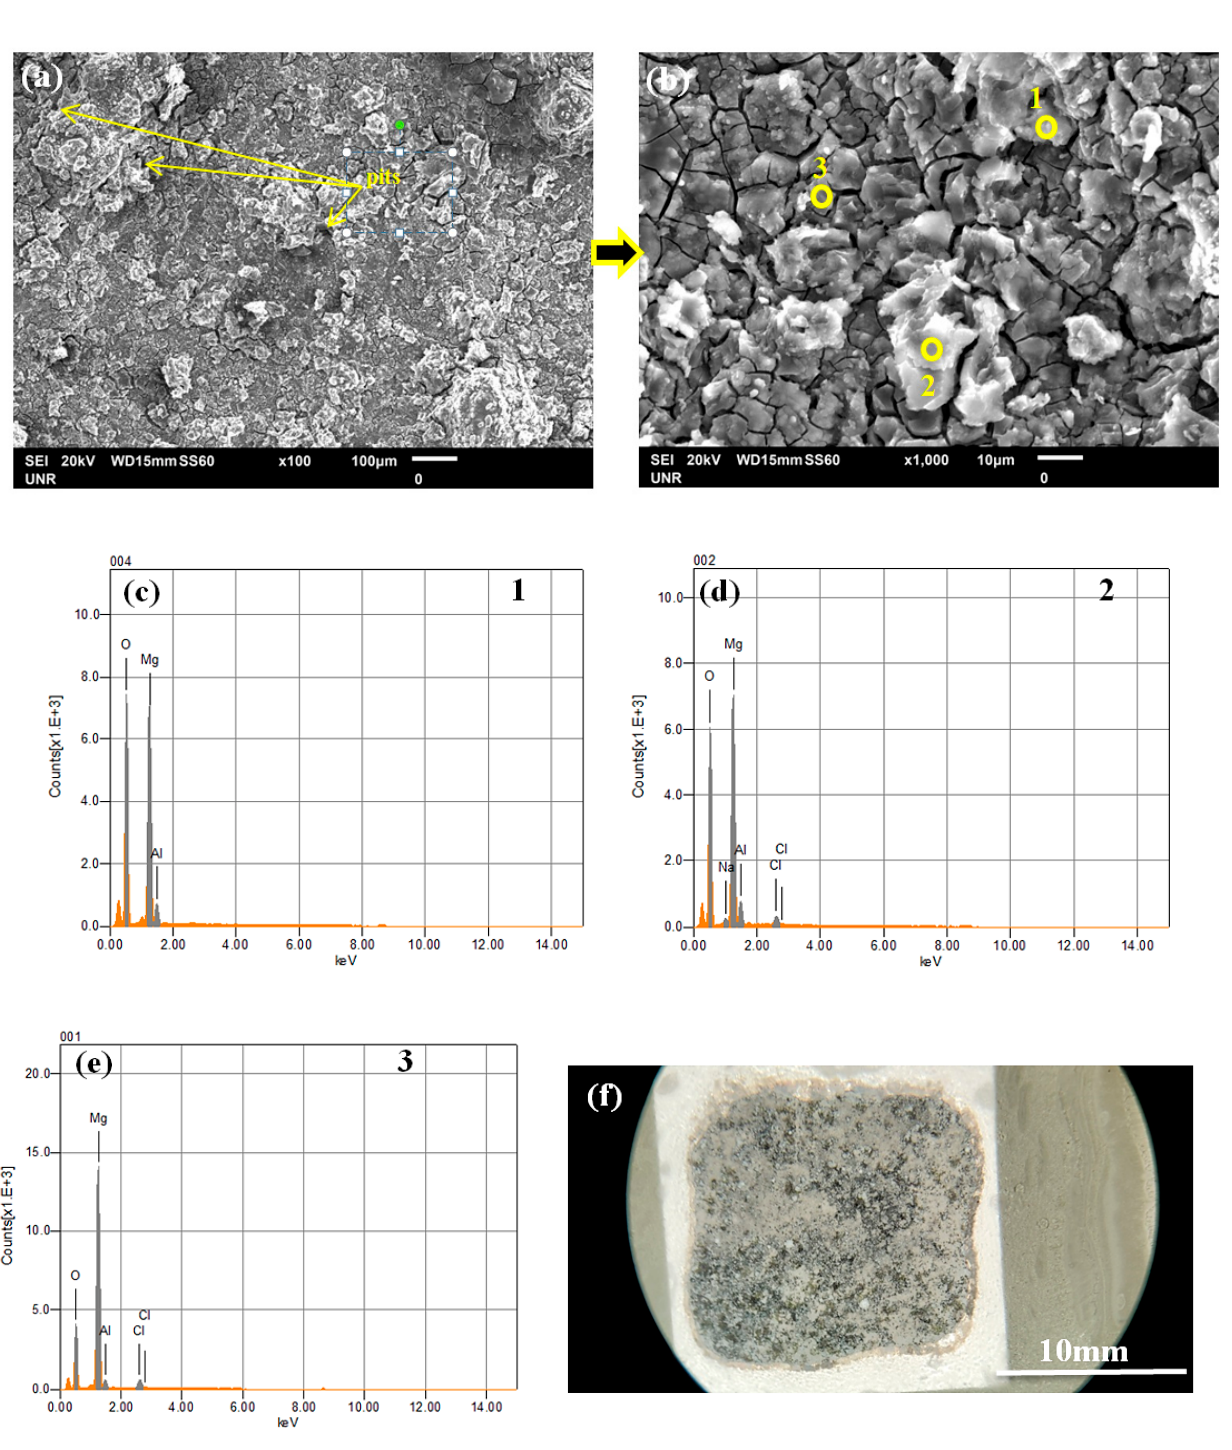
Figure 9. ( a , b ) surface morphology of ground surface of uncoated AZ31B Mg alloy after immersion test in 3.5 wt % NaCl solution for 11 days, EDS analysis of 1 ( c ), 2 ( d ), 3 ( e ) and ( f ) stereo microscope image at 50 ×